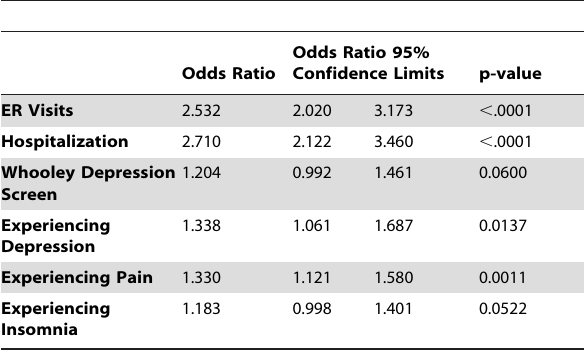
Table 4. Adjusted healthcare resource use and depression, pain, and insomnia, in patients with AF and matched